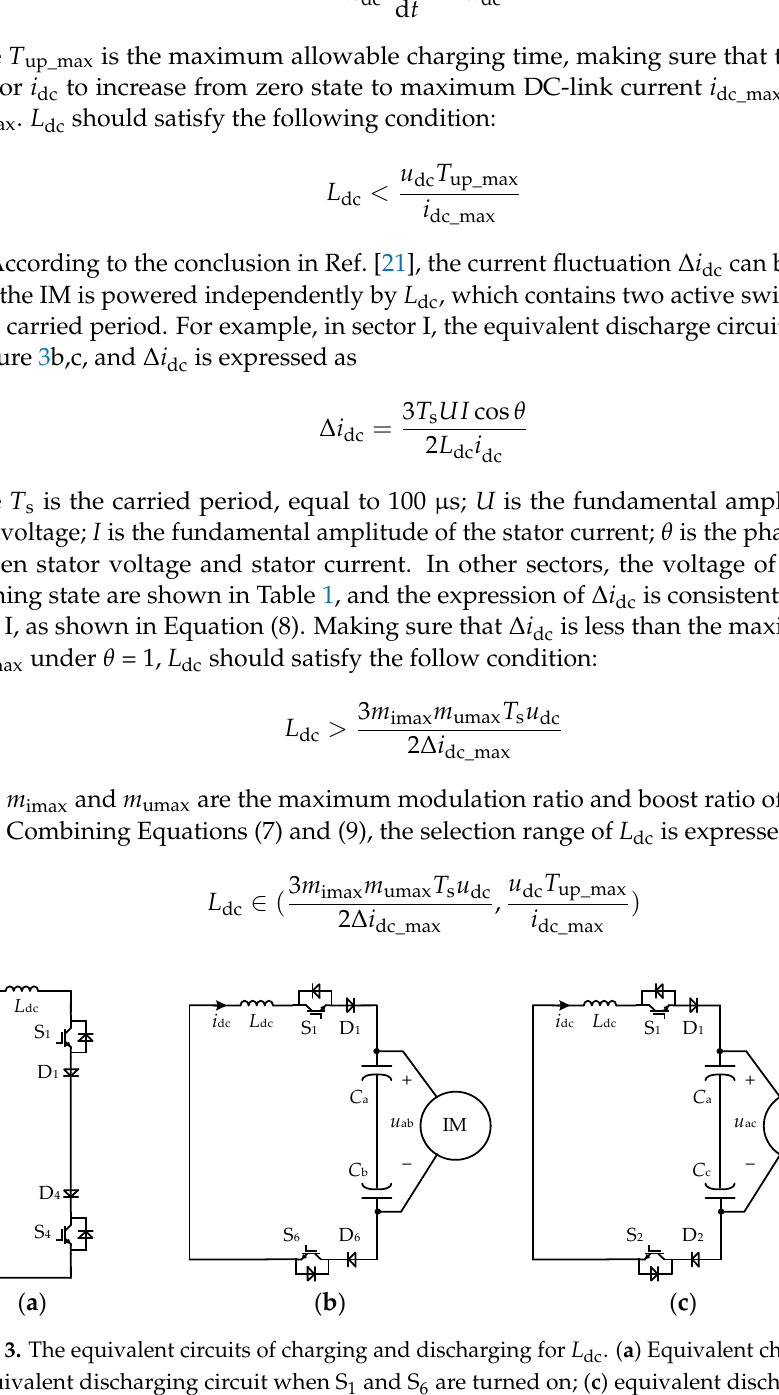
Table 1. The voltage of L dc and switching state in sectors II–VI. Sector